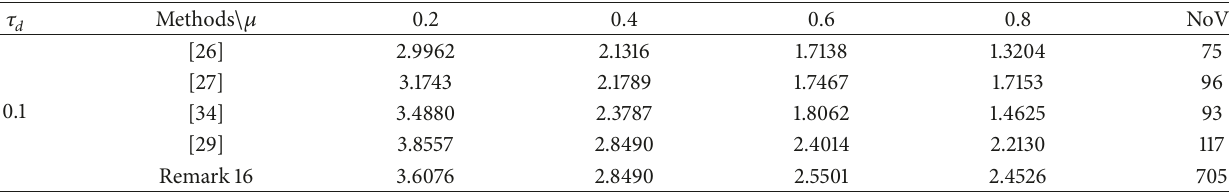
Table 1: MADUBs ℎ for different 𝜇 (Example 1).